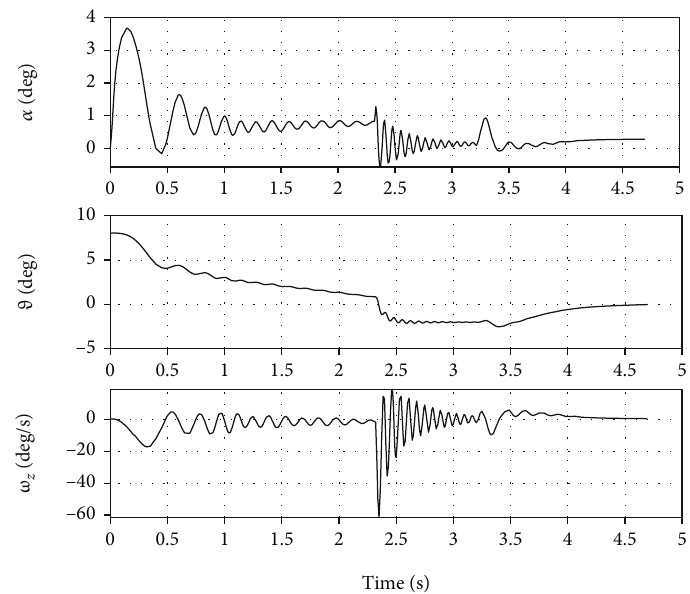
Figure 6: AoA, pitch angle, and pitch rate.